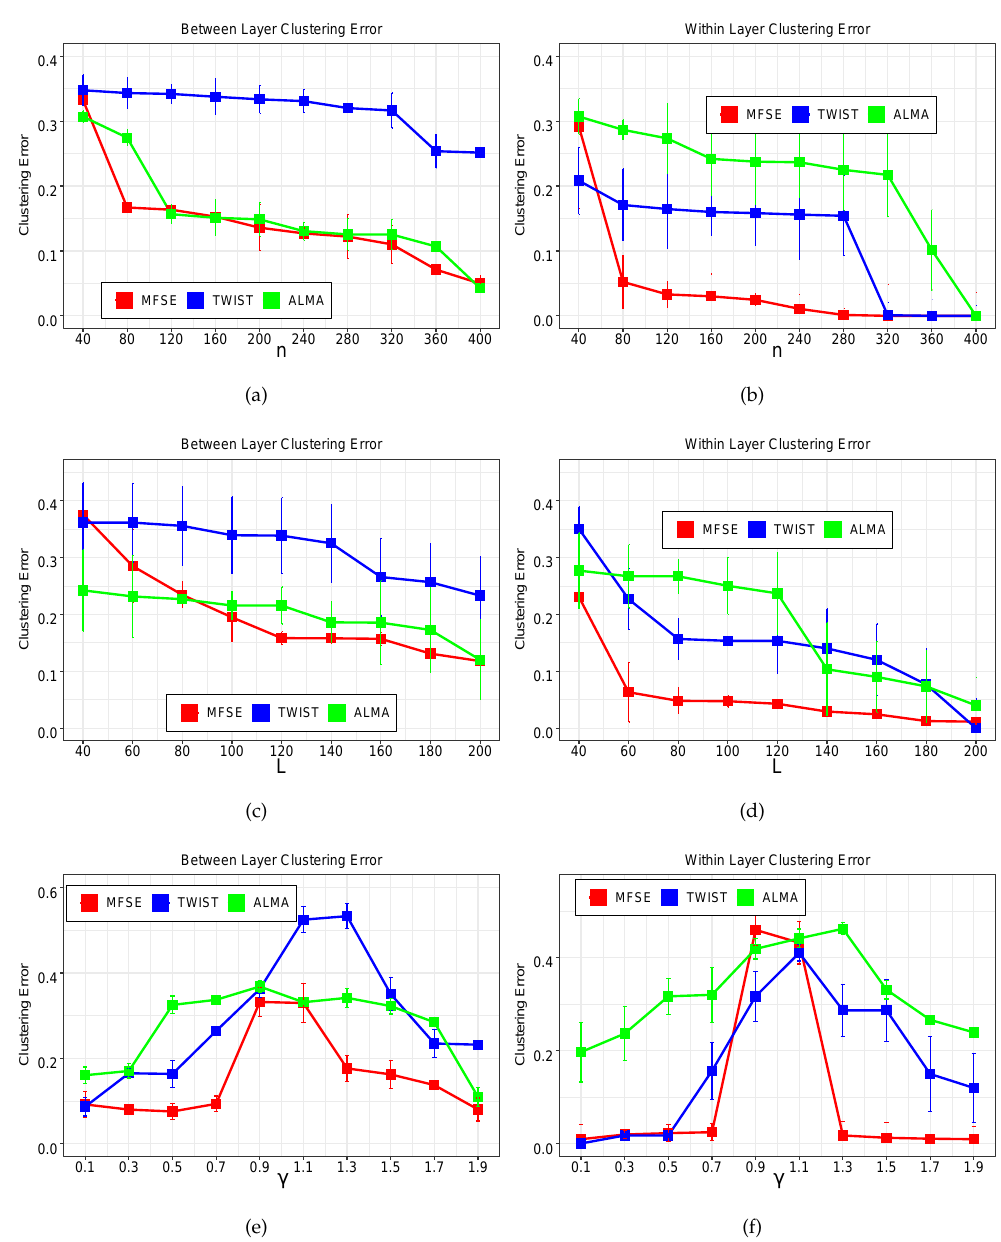
Figure 2. ( a , b ) Between-layer clustering results and within-layer clustering results returned by three methods as the number of nodes n increases; ( c , d ) Between-layer clustering results and within-layer clustering results returned by three methods as the number of layers L increases; ( e , f ) Between-layer clustering results and within-layer clustering results returned by three methods as γ varies. Each data point shows the average result and the error bar determines the range of one standard deviation from the